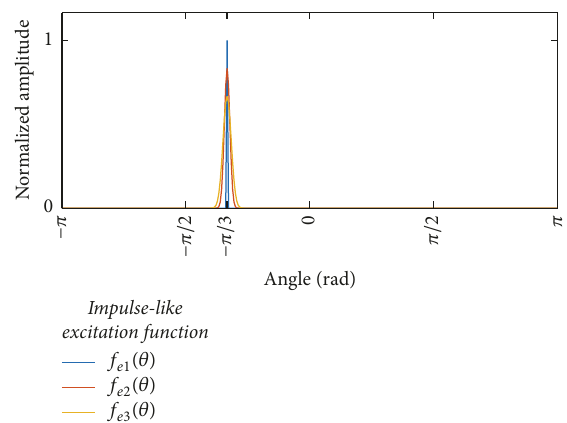
Figure 2: Illustration of three distinct impulse-like forces for the single localized bearing fault with respect to angular position of the rolling element.